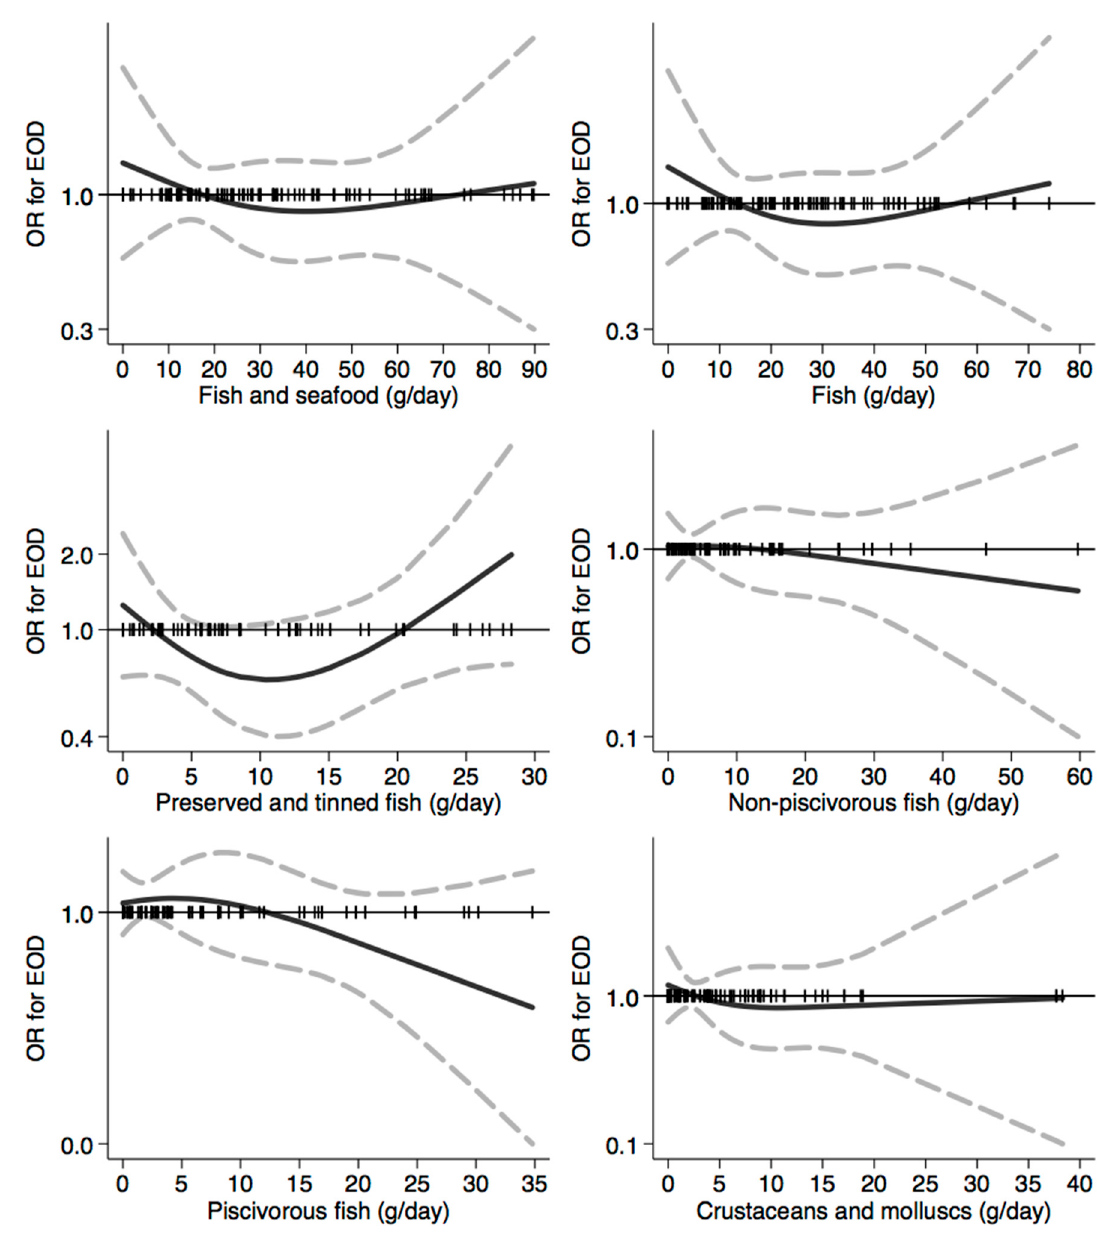
Figure 4. Spline regression analysis of early-onset dementia (EOD) risk for increasing intake of fish and seafood. The black line indicates odds ratios for dementia risk; dash gray lines are 95% confidence limits; the reference line at 1.0 with black spikes indicates the distribution of participant intake.